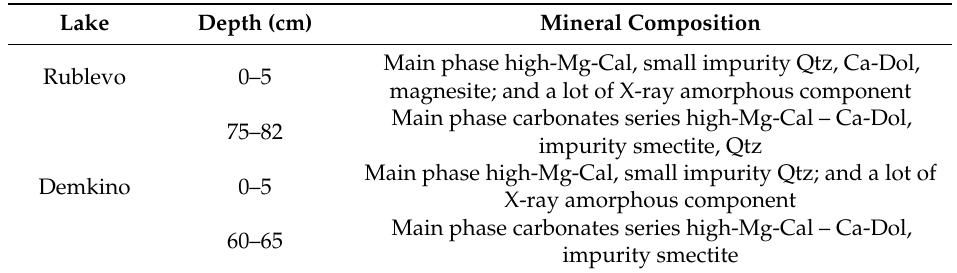
Table 3. Bottom sediment mineral composition of small lakes Rublevo and Demkino (Kulunda